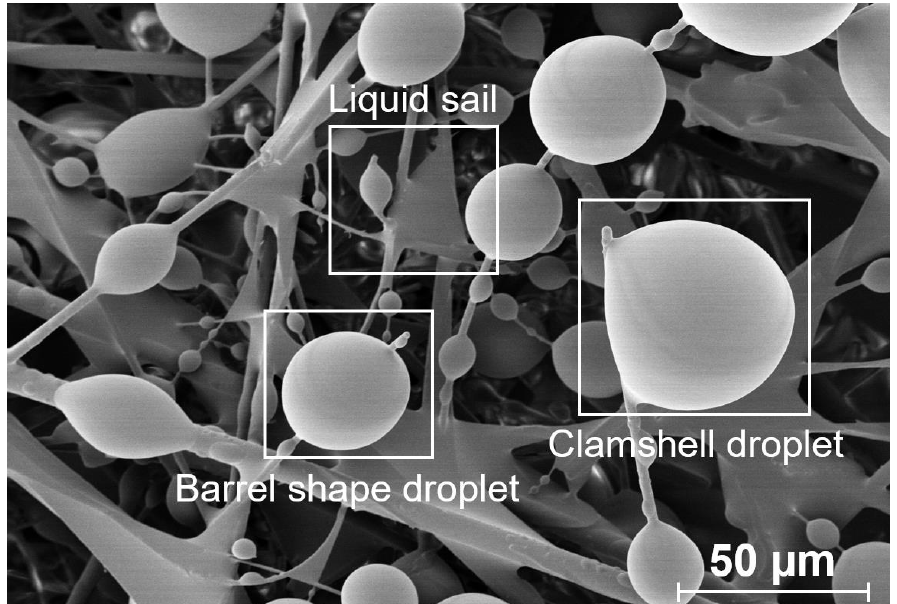
Figure 1. SEM image of solidified droplets on a wettable micro glass fiber medium (thickness 0.46mm, porosity 0.95) to illustrate different deposited liquid structures occurring during the filtration of liquid droplets. Front view of the medium showing mainly barrel shape droplets, some clamshell droplets and in the background liquid sails between adjacent fibers. The filter medium was loaded for 8 h with atomized surrogate liquid (NOA 61) at a filtration velocity of 25cm s − 1 and polymerized by a UV light source (procedure according to the experiments of Kampa et al.